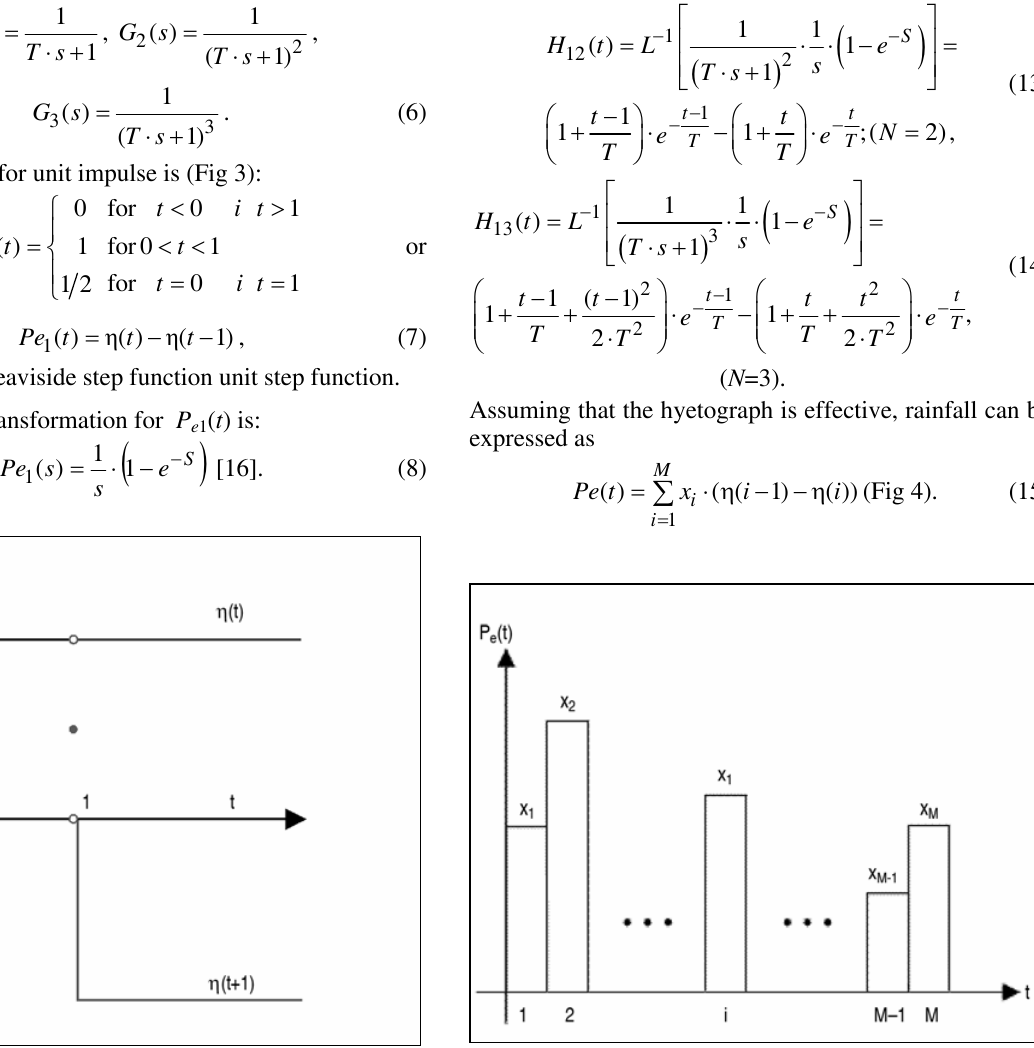
Fig 3 . Unit impulse Fig 4 . Hyetograph of effective